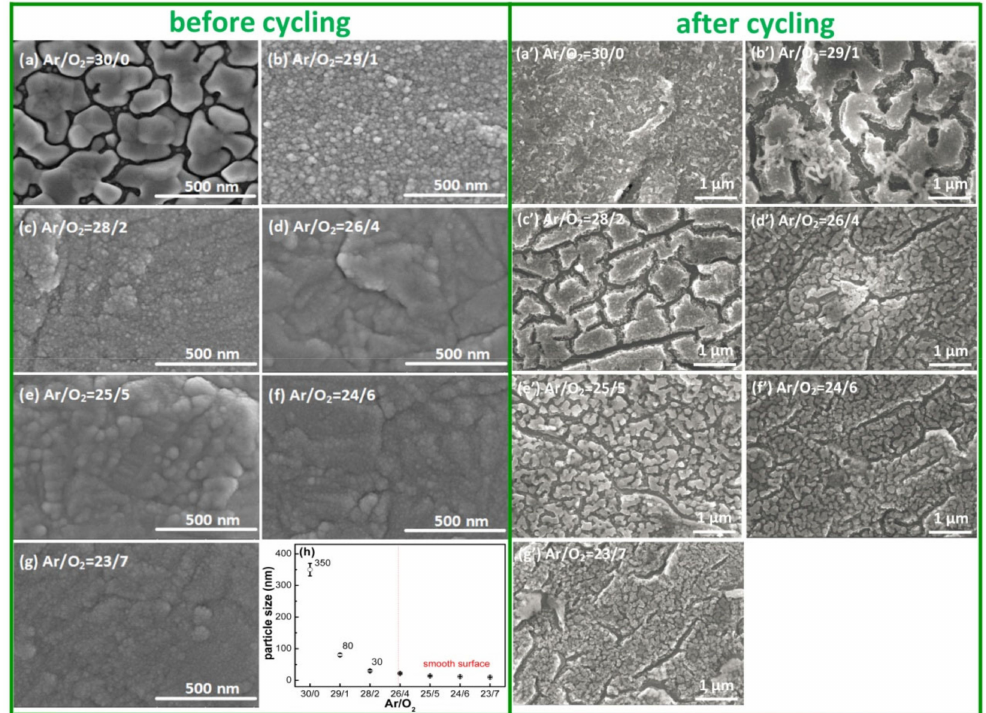
Figure 2. The surface SEM images of the SnO x films before and after cycling, deposited with different Ar/O 2 flow ratios: ( a , a’ ) Ar/O 2 = 30/0, ( b , b’ ) Ar/O 2 = 29/1, ( c , c’ ) Ar/O 2 = 28/2, ( d , d’ ) Ar/O 2 = 26/4, ( e , e’ ) Ar/O 2 = 25/5, ( f , f’ ) Ar/O 2 = 24/6 and ( g , g’ ) Ar/O 2 = 23/7, and ( h ) represents the average particle size on SnO x